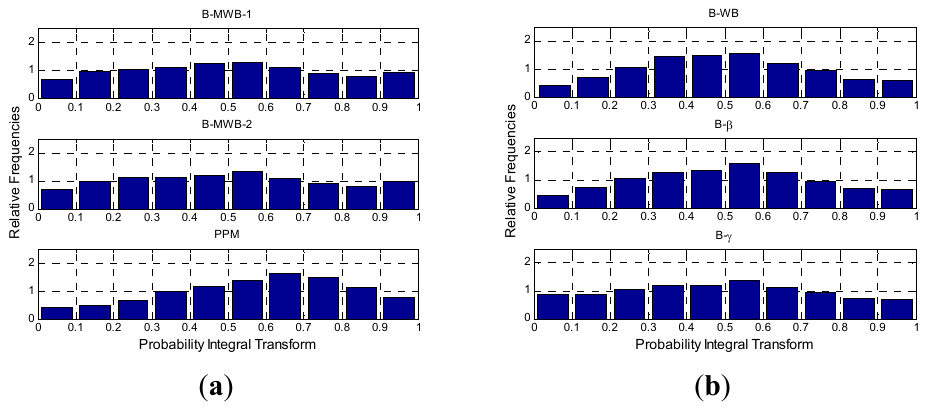
Figure 4. PIT histograms for: ( a ) Proposed methods: B-MWB-1 and B-MWB-2 cases, and PPM; ( b ) Bayesian methods with unimodal distributions: B-WB, B- β and B- γ cases.